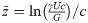
Inclusive fitness depending on offspring condition c and parental investment z.(A) Parental fitness (function u according to Eq 2 without signal cost f(x)). (B) Offspring fitness (function v according to Eq 1 without signal cost f(x)). Red line connects the equilibrium z values where z˜=ln(γUcG)/c holds. Parameters are Z = 10, G = 0.08, U = 1, γ = ½, ψ = ½.